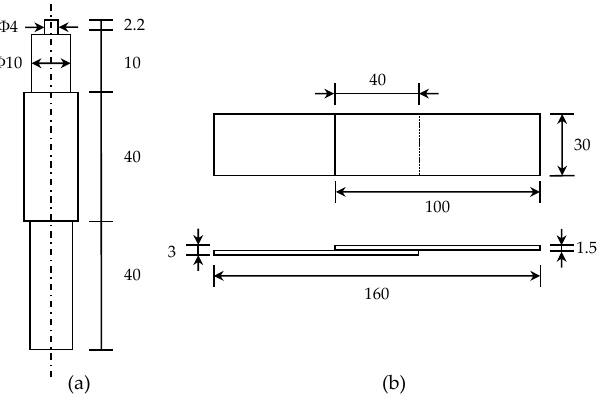
Figure 5. Illustration and dimensions of ( a ) the FSSW tool (H13 hot-work tool steel) and ( b ) Al 1050 strips (all dimensions are in mm). Table 1. Aluminum Alloy Al 1050 chemical composition and mechanical